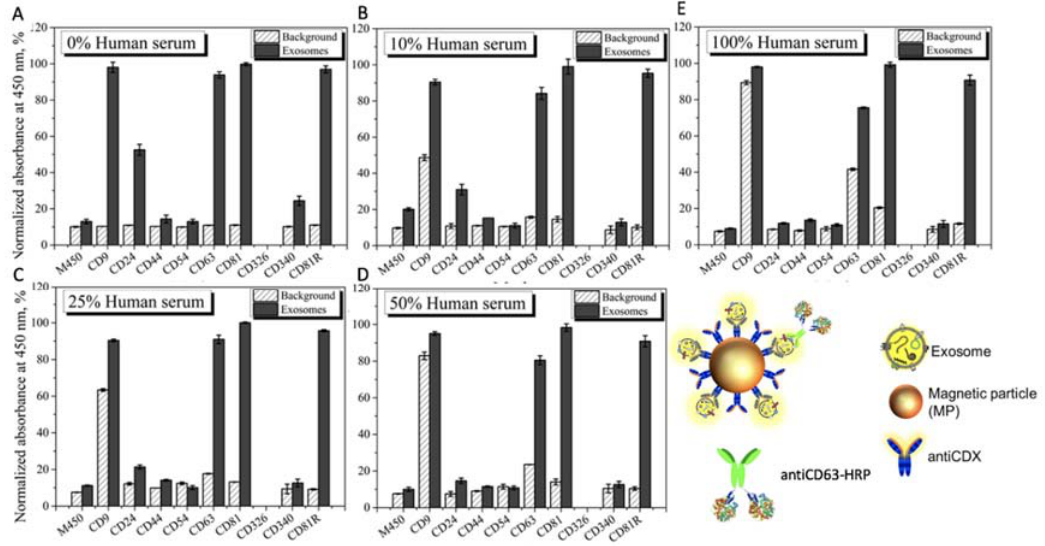
Figure 8. Evaluation of the matrix effect in exosome ‐ depleted human serum for MCF7 exosomes detection using antiCDX ‐ MPs modified with antibodies against CD9, CD24, CD44, CD54, CD63, CD81, CD340 and CD81R (rabbit polyclonal) biomarkers for the IMS, followed by direct labeling with an antiCD63 ‐ HRP antibody (1.24 μ g mL − 1 ). Detection of exosomes in ( A ) 0%; 10 mmol L − 1 phosphate ‐ buffered saline/PBS (standard for no matrix effect), ( B ) 10%, ( C ) 25%, ( D ) 50% and ( E ) 100% exosome ‐ depleted human serum (undiluted human serum). The concentrations of MPs and exosomes were set at 1 × 10 6 MPs and 4 × 10 9 exosomes per assay, respectively. The background (as a negative control without exosomes) are also shown in all the experiments. The error bars show the standard deviation for n = 3.